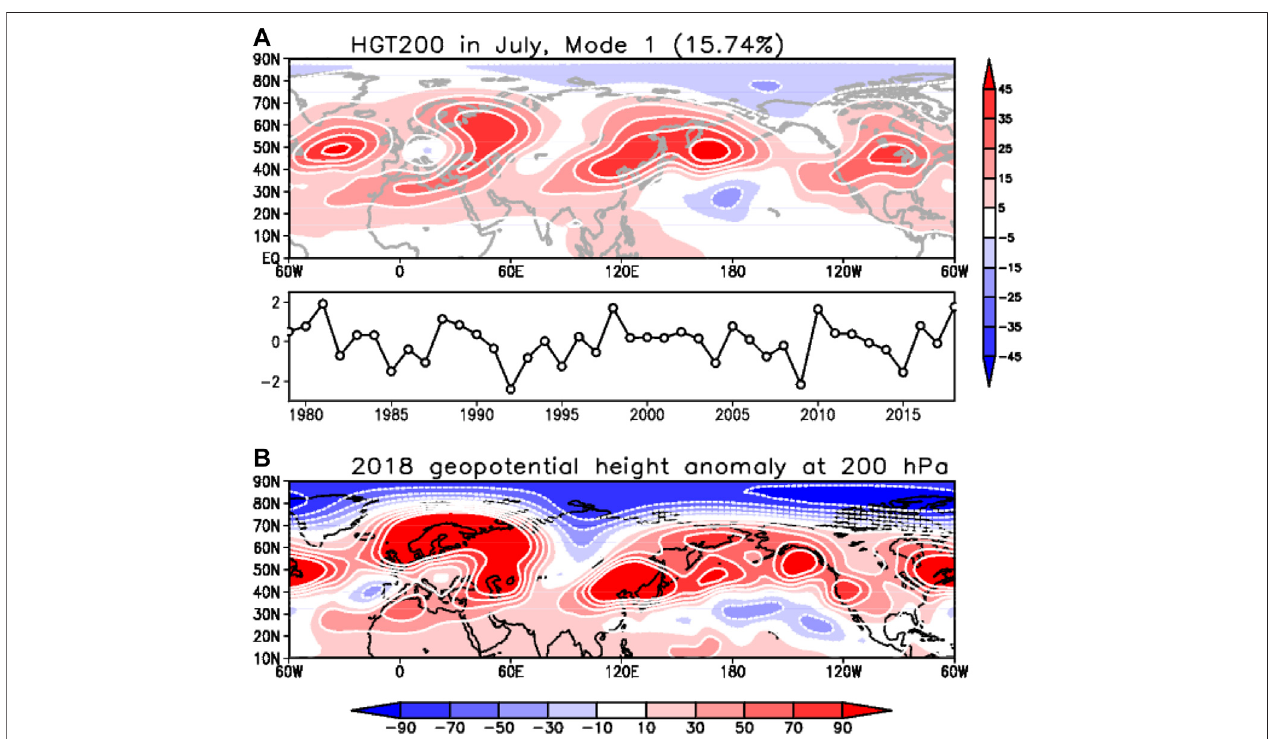
FIGURE 1 | (A) The EOF1 of geopotential height at 200 hPa in July and (B) the anomaly pattern in July 2018.